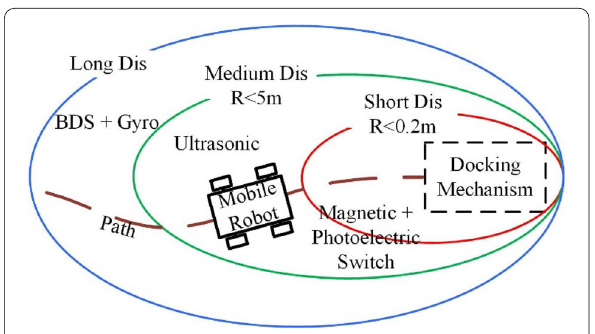
Figure 1 The schematic of hybrid navigation